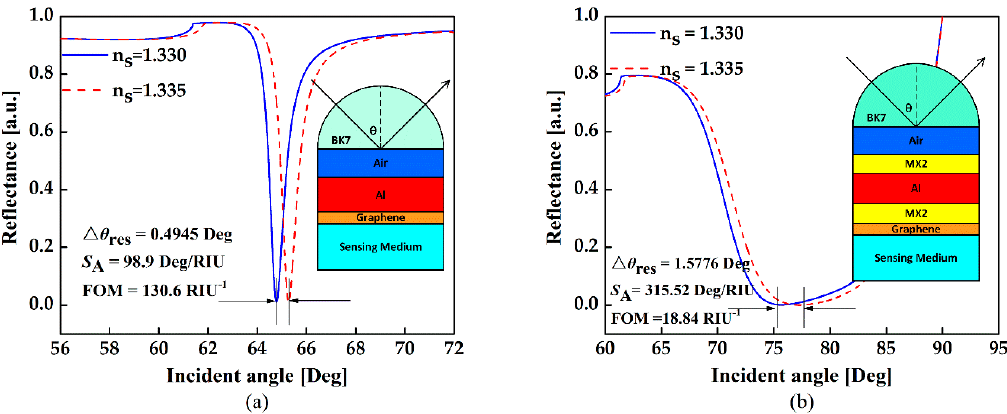
Figure 5. Variation of the reflectance with respect to the incident angle for ( a ) the conventional biochemical sensor based on single Al film, and ( b ) the proposed configuration based on optimal angle sensitivity.